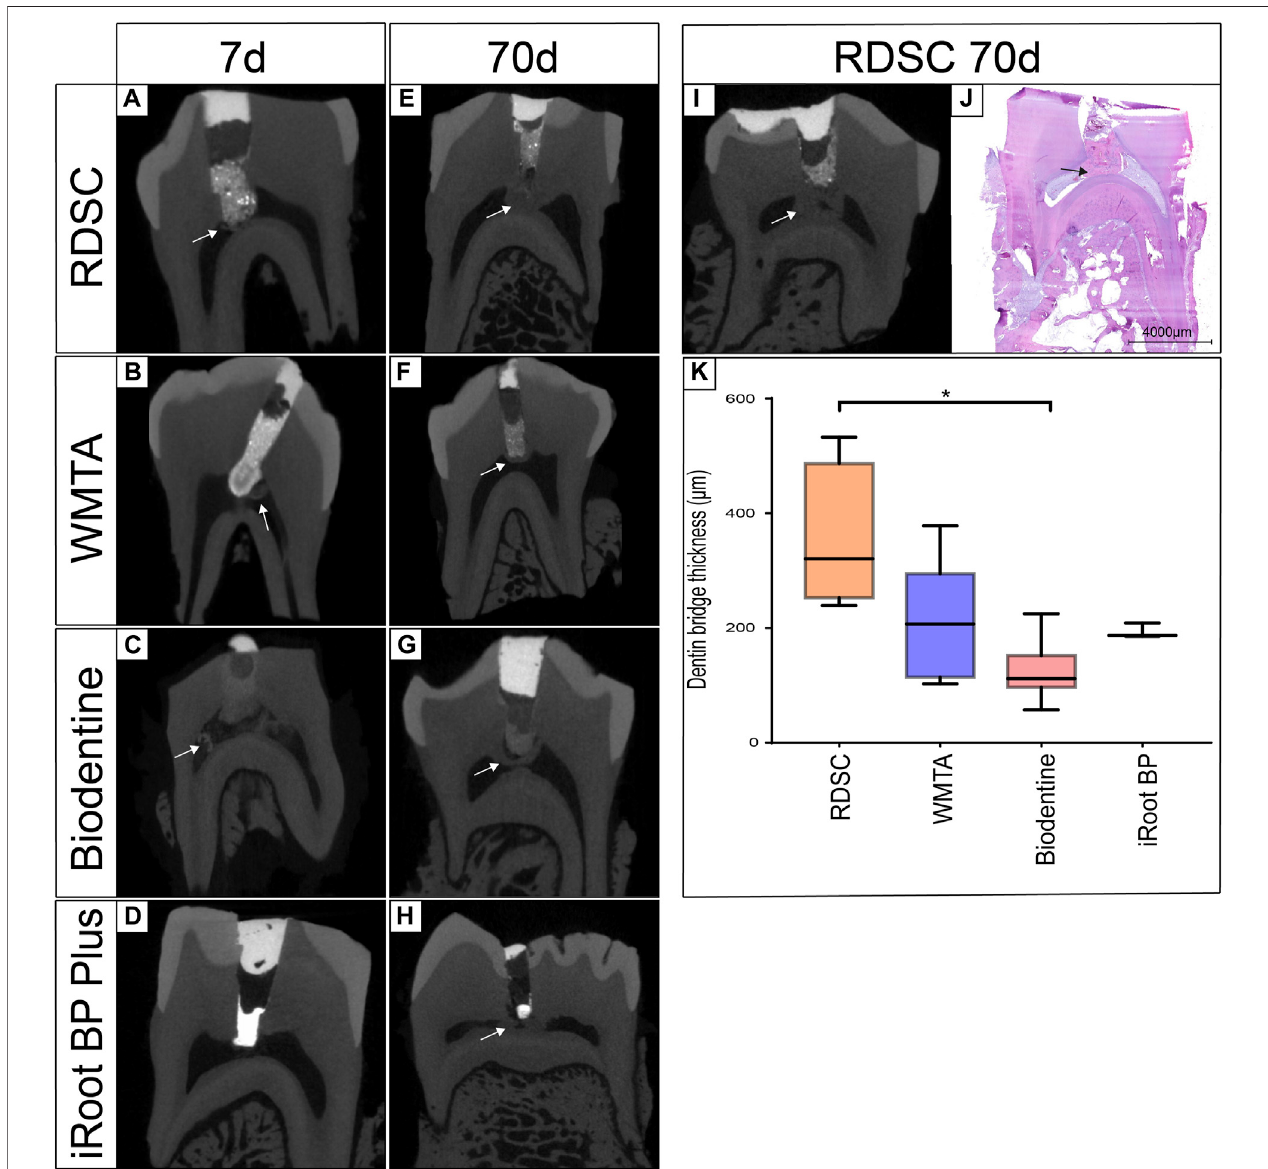
FIGURE 6 | Three-dimensional micro-CT reconstruction of teeth capped for 7 or 70 days in the in-vivo miniature pig model by RDSC (A,E,I) , WMTA (B,F) , Biodentine (C,G) or iRoot BP Plus (D,H) . The hard tissue bridge was con fi rmed to be reparative dentin bridge by histological assay (J) . The dentin bridge thickness of each 70 days group was compared by three-dimensional micro-CT reconstruction (K) (* indicates a signi fi cant difference, p < 0.05).